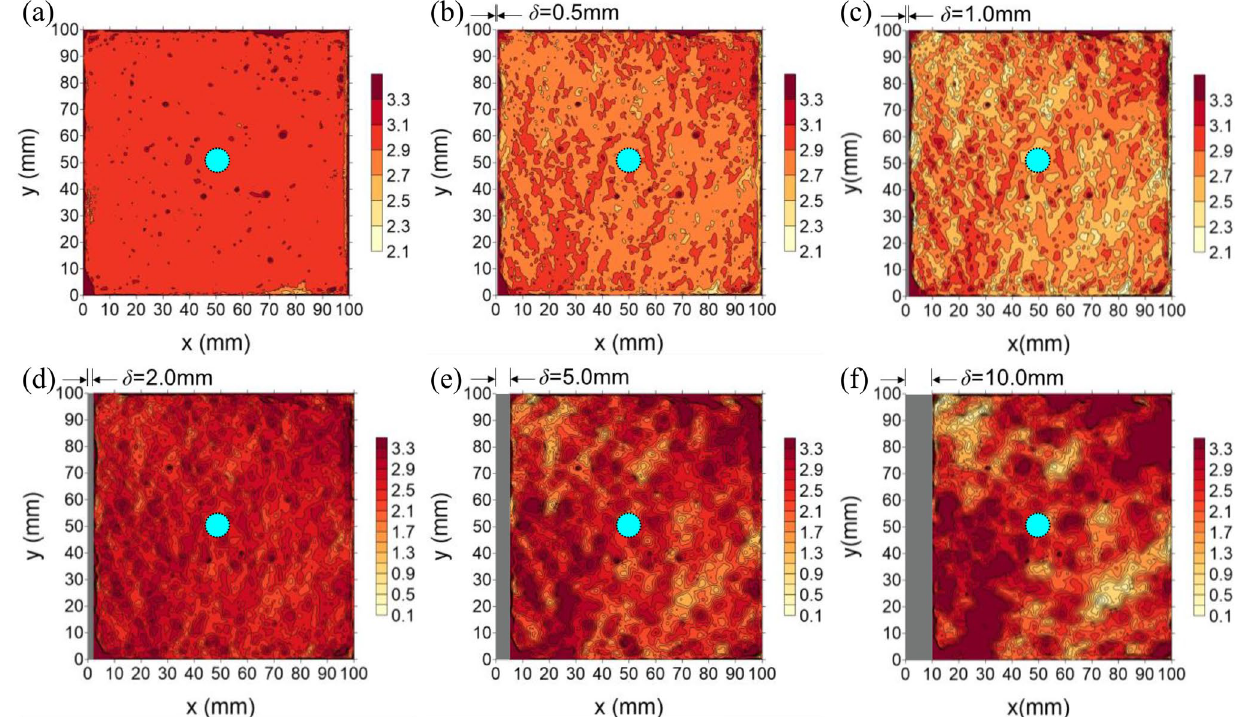
Figure 9. Evolution of thickness distribution with shear displacement and a sand fill layer (“dashed blue” is the water injection hole), ( a ) δ = 0 mm, ( b ) δ = 0.5 mm, ( c ) δ = 1.0 mm, ( d ) δ = 2.0 mm, ( e ) δ = 5.0 mm, ( f ) δ = 10.0